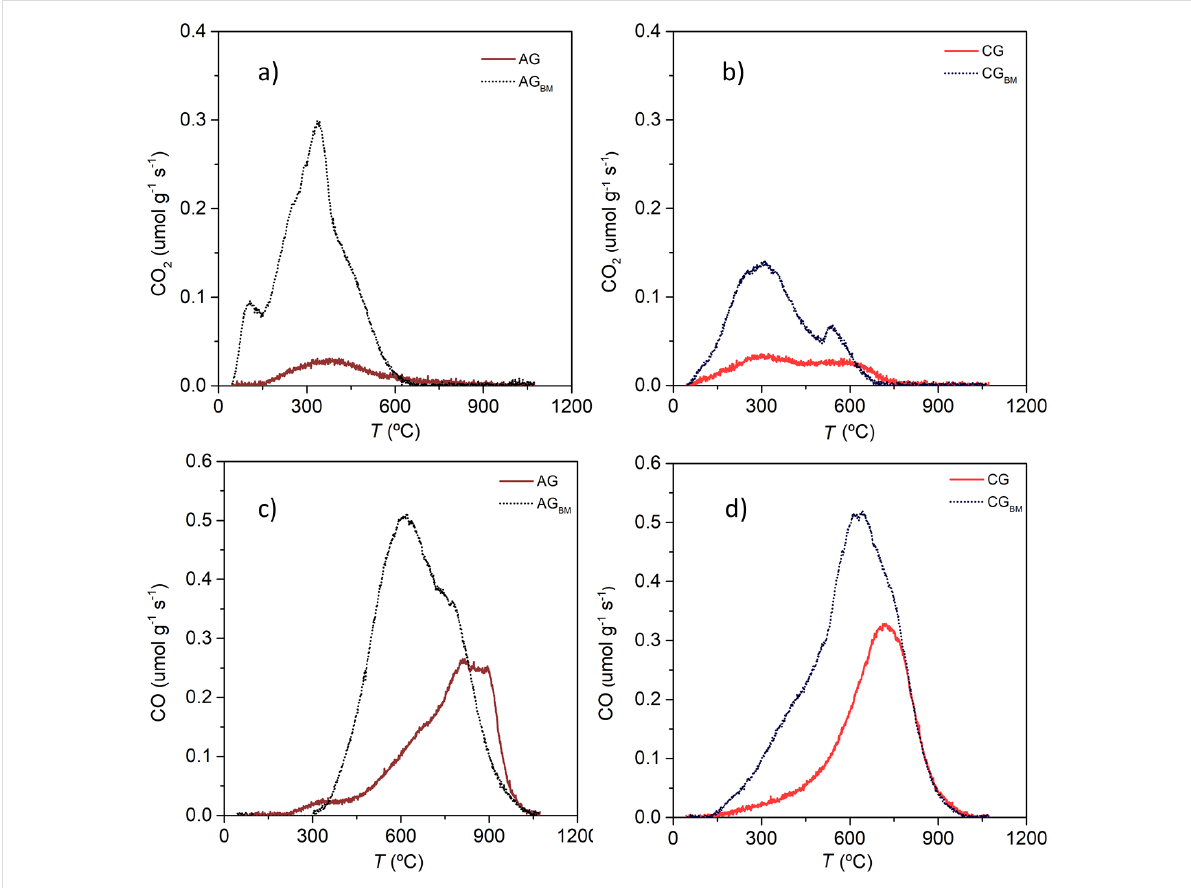
Figure 5: TPD profiles of CO 2 for activated samples (a) and carbonized samples (b) and CO profiles of activated samples (c) and carbonized sam- ples (d).